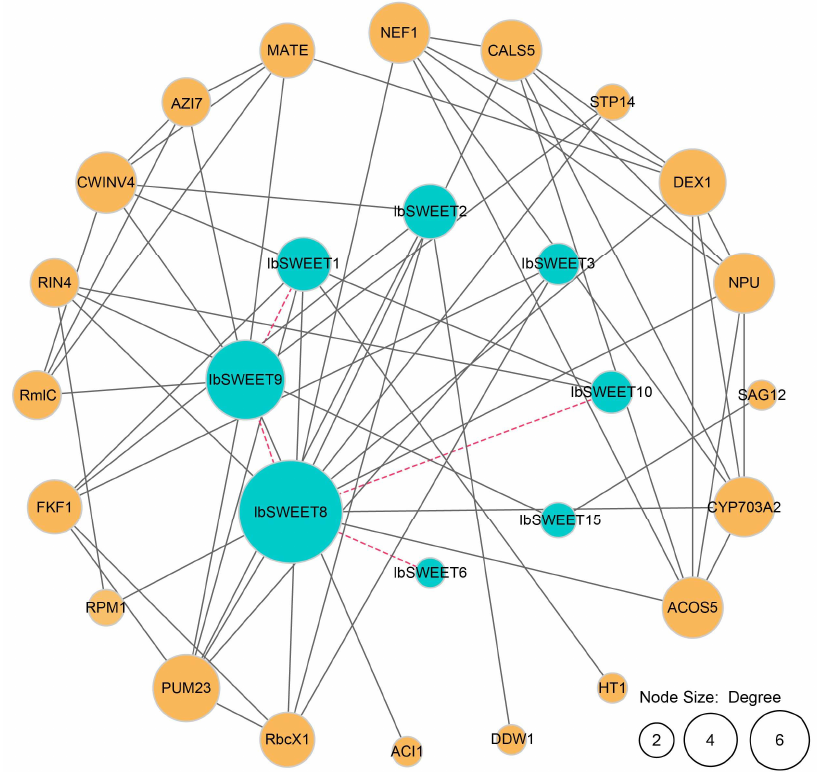
Figure 6. Functional interaction networks of IbSWEETs in I. batatas according to orthologues in Arabidopsis. Network nodes represent proteins, and lines represent protein–protein associations. The node size represents the number of proteins that interact with each other. The dotted line represents the interaction between the different SWEETs. The solid line represents the interaction between SWEETs and other